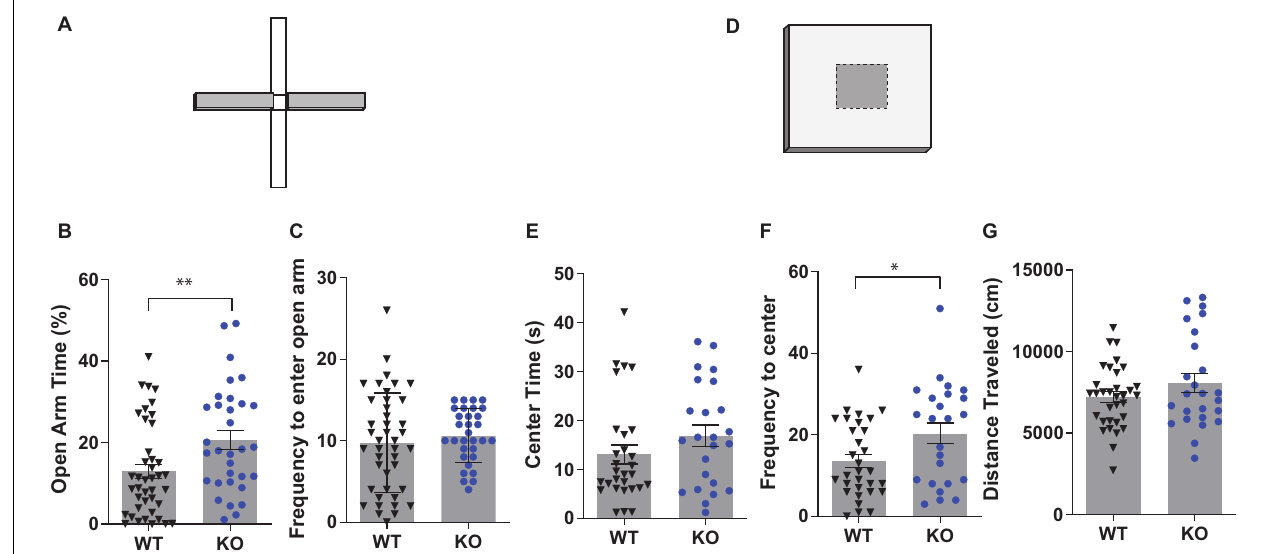
FIGURE 1 | Mice lacking GPR83 have a decrease in anxiety-related behaviors. Wild-type (WT) and GPR83 knockout (KO) mice were screened on the elevated plus maze (A) and the amount of time spent on the open arms (B) and frequency to enter the open arms (C) measured. WT and GPR83 KO mice were screened in